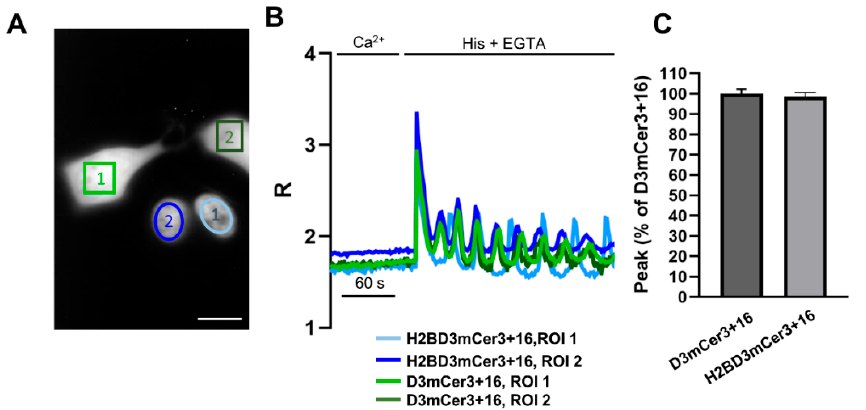
Figure 4. Simultaneous imaging of cytosolic and nuclear Ca 2+ kinetics. ( A ) Representative image of the acceptor channel of cocultured HeLa cells transfected with H2BD3mCerulean3+16 or D3mCerulean3+16. ( B ) Representative kinetics of nuclear and cytosolic R values, measured by recording the signal from the indicated regions of interest (ROIs), in HeLa cells expressing either H2BD3mCerulean3+16 (light blue circle 1, dark blue circle 2) or D3mCerulean3+16 (light green rectangular 1, dark green rectangular 2) and stimulated with histamine (His, 100 µM), as described in Figure 1C. ( C ) The bar chart shows the mean cytosolic (dark gray) and nuclear (light gray) Ca 2+ peak values elicited by histamine application in HeLa cells expressing the D3mCerulean3+16 (dark gray) or H2BD3mCerulean3+16 (light gray) as mean ± SEM of n ≥ 17 cells.